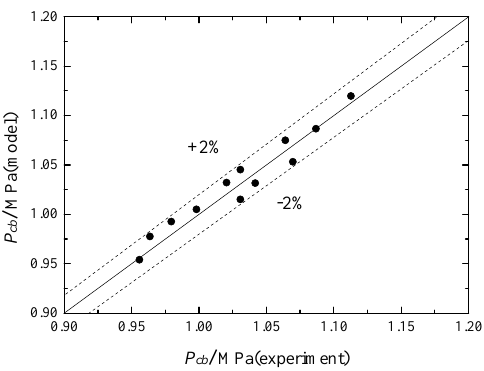
Figure 7. Comparisons of theoretical breakdown condensing pressures with experimental values using R134a as a working